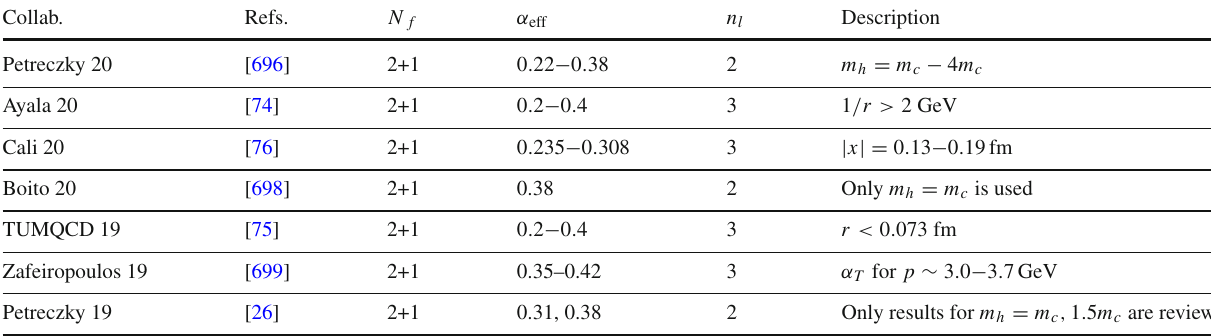
Table 171 Renormalization scale and perturbative behaviour of α s determinations for N f = 3 Collab.